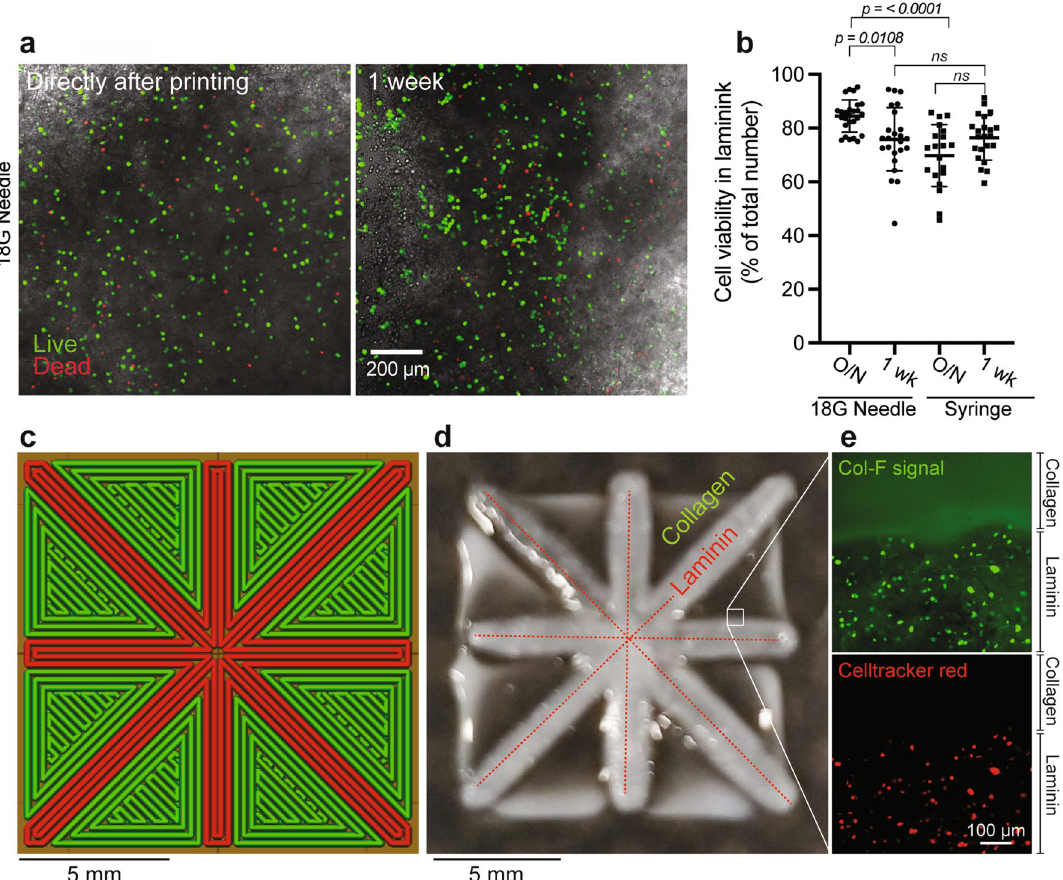
Figure 4. Multimaterial bioprinting using the open source bioprinter. ( a ) Example of fluorescein diacetate (live cells; green) and propidium iodide (dead cells; red) staining of MDA-MB-231 breast cancer cells extruded in laminin bioink directly after extrusion through an 18G needle and following 1 week of culture. ( b ) Comparative analysis of cell viability following overnight culture (O/N) and one week after extrusion of cells in laminin bioink through an 18 G needle or manually deposited directly from a syringe. ( c ) Design of the multimaterial construct to be printed using both collagen (green) and cell-laden laminin (red) bioinks, as viewed from above illustrating the print path. ( d ) Image of the bioprinted multimaterial construct. ( e ) Col-F staining of the collagen bioink (green) and Celltracker red staining of MDA-MB-231 cells distributed in the laminin